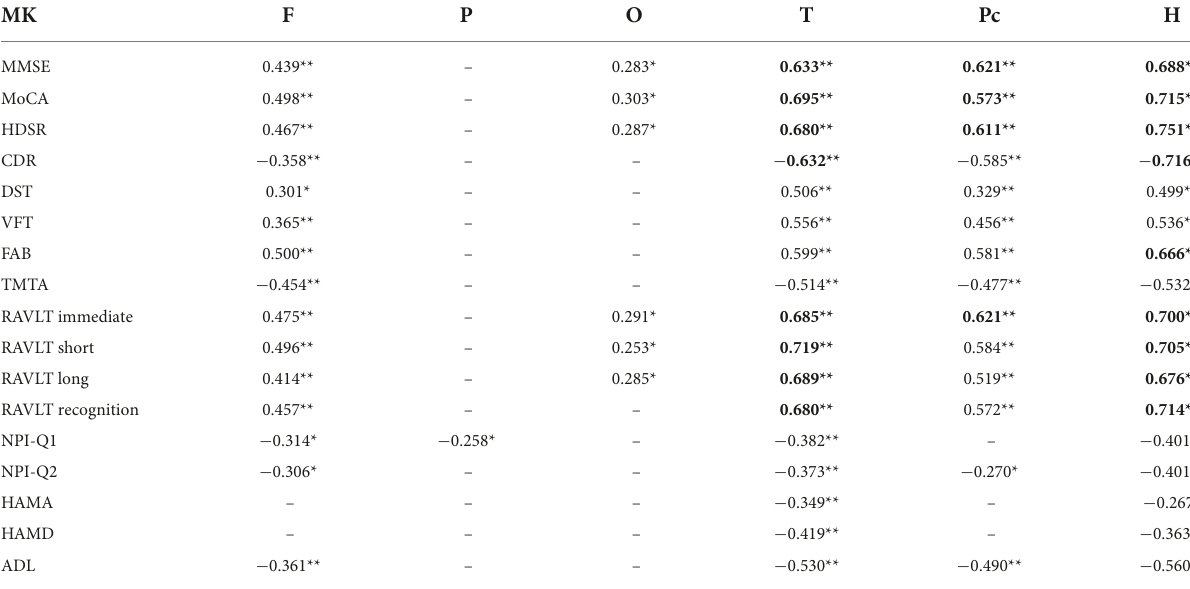
TABLE 8 Pearson’s correlation analysis between MK and neuropsychological test.